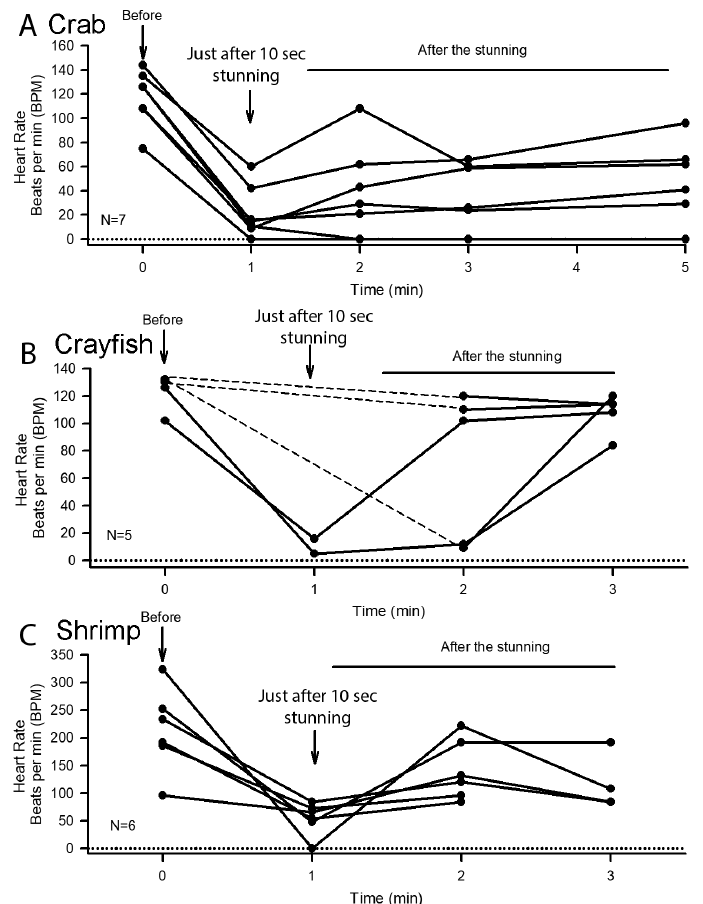
Figure 7. The effect of 10 s at 120 V with AC electric stunning of crab ( A ), crayfish ( B ) and shrimp ( C ). Rates were able to be obtained immediately after stunning for most animals except for some of the crayfish (dashed lines) due to electrical saturation of the amplifier during the stunning. In only one animal in each species did the heart stop beating after the 10 s window; in all but one case, for all three species, the rates increased after the electric stunning.